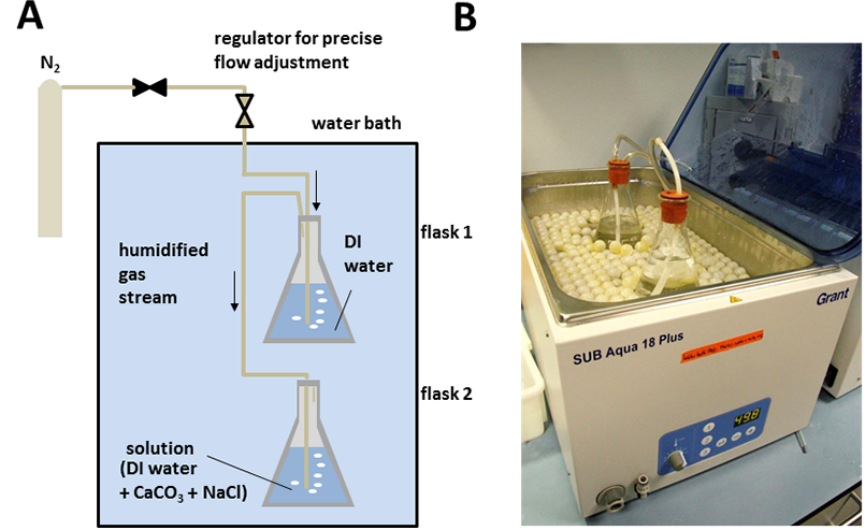
Figure 1. Sketch (a) and photograph (b) of the experimental setup used to precipitate vaterite. In the first step, CaCO 3 is dissolved in de-ionized (DI) water (outside the water bath), which is filtered after >3h to remove any undissolved components. The solution is then transferred to a temperature-controlled water bath for thermal and isotopic equilibration (flask 2 in a ). NaCl is added after the equilibration step. Mineral formation is induced by slow bubbling of N 2 through the solution. The gas stream through the solution in flask 2 is humidified by passing it beforehand through another flask filled with de-ionized water (flask 1). Table 1. Experimental conditions during laboratory precipitation of CaCO 3 (see Sect.